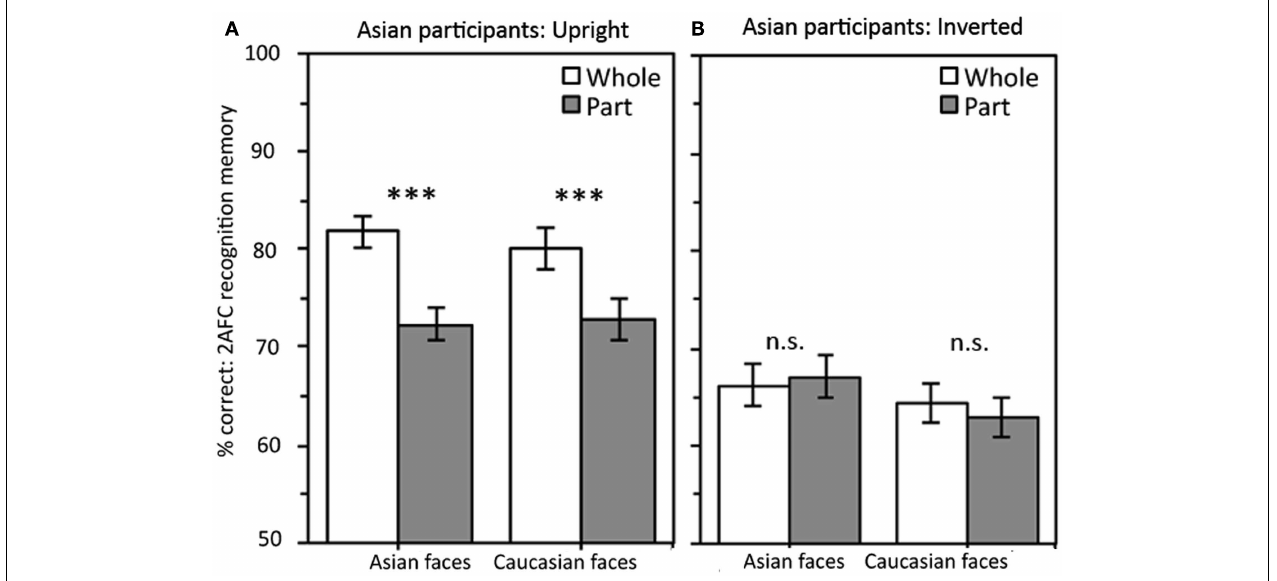
are as appropriate for making the within-subjects comparison between whole and part conditions (i.e., ± 1 SEM of the whole – part difference scores). *** p ≤